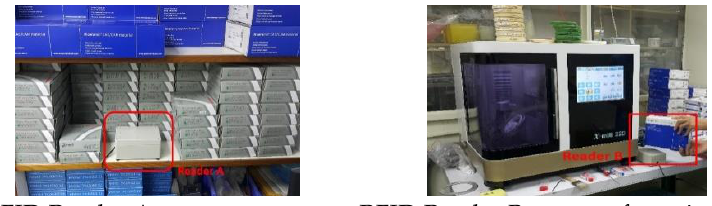
Figure 8. The RFID readers at storage room and manufacturing area.